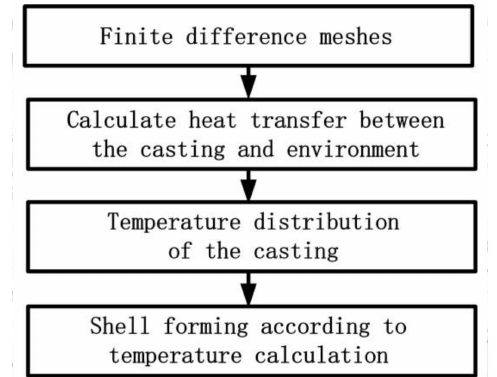
Figure 3. The process for generating the thickness-varying